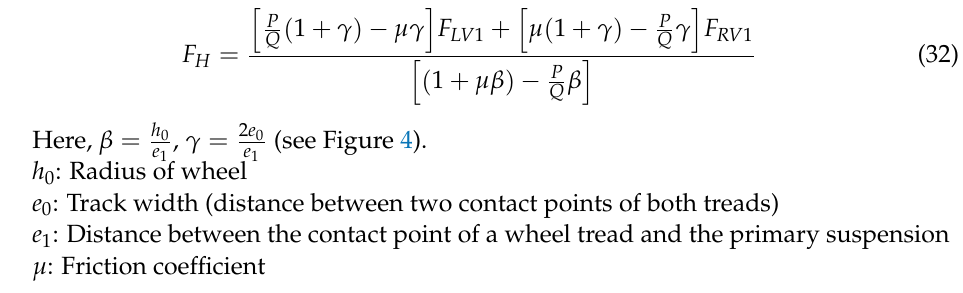
Curved track (Lateral Acc. = 0.5 m/s 2 )